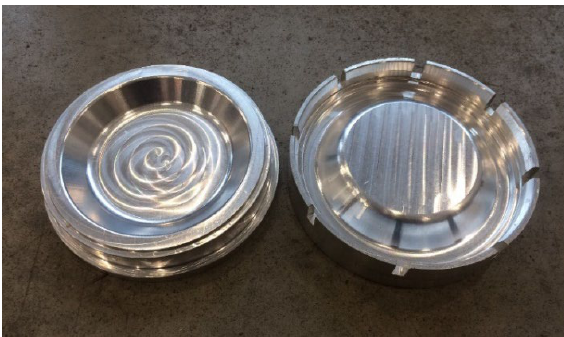
Fig. 5. Die (on the left) and punch (on the right) produced for the compressing of